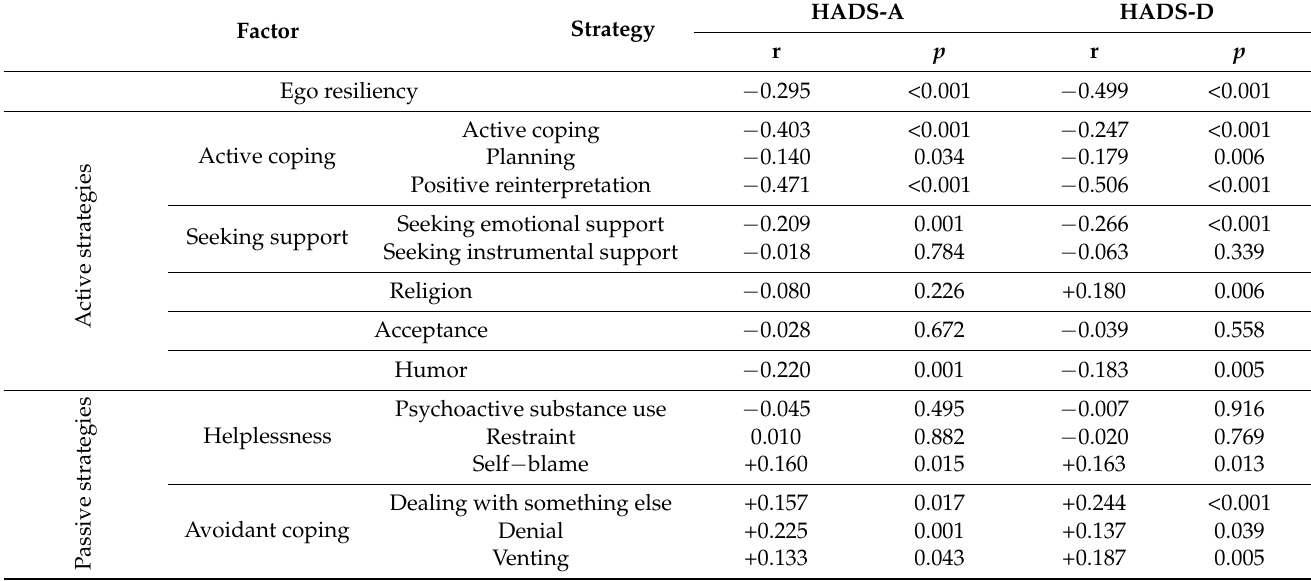
Table 3. Correlations of HADS with ego-resiliency and MINI-COPE inventory in the PCOS group.